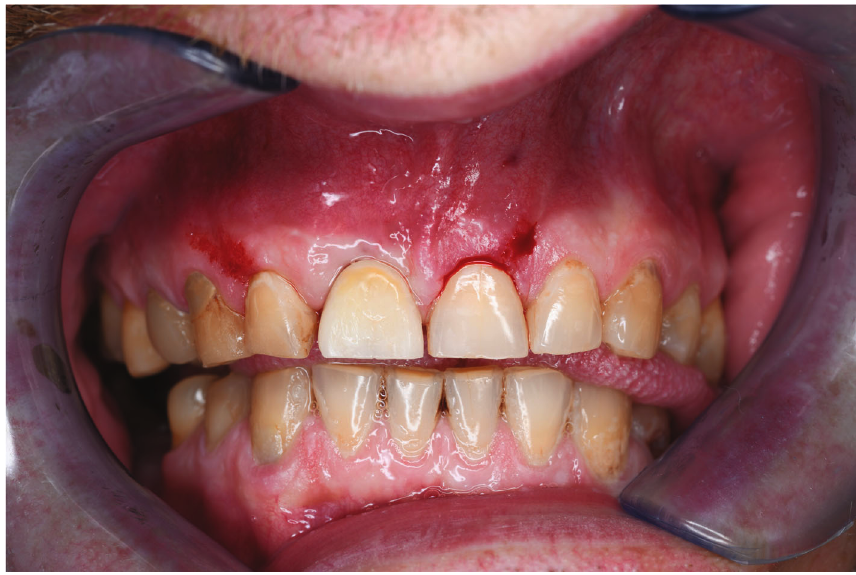
Figure 14: Surgical crown lengthening to level the gingival margin.